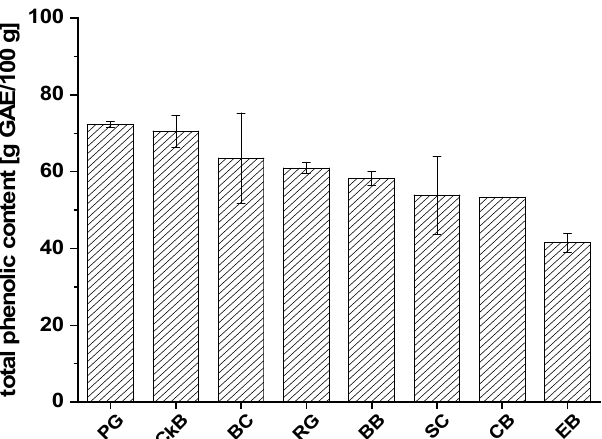
Figure 2. The average total phenolic contents of fruit juice extracts from chokeberry (CkB), cranberry (CB), pomegranate (PG), blueberry (BB), elderberry (EB), red grape (RG), sour cherry (SC), and black currant (BC) defined as gallic acid equivalents (g GAE/100 g ± SD).